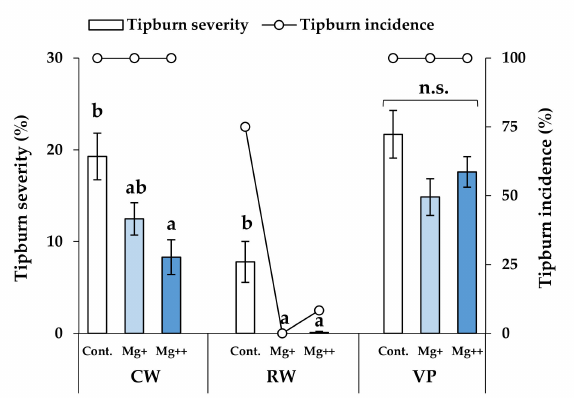
Figure 1. Tipburn severity and incidence in each cultivar and each treatment at 8 weeks. Data are means ± SE. Significant differences among means are indicated by different letters. n.s. represents no significant differences among the treatments. Cultivars: Celeb Wine (CW), Reina White (RW), and Voyage Peach (VP).